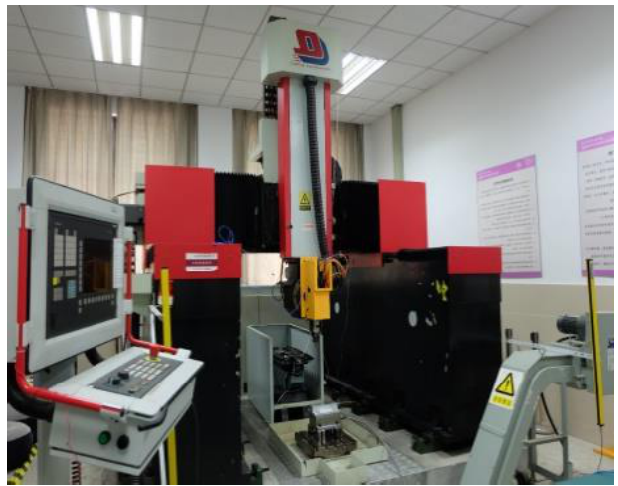
Figure 3. QLM27100-5X machine tool.